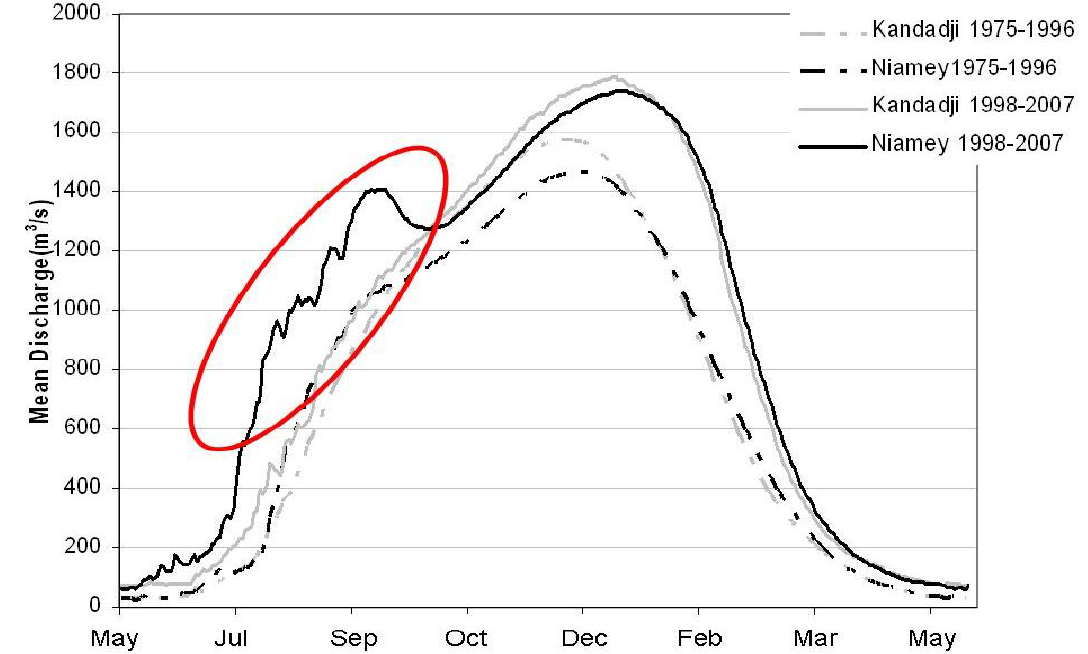
Figure 7. Average hydrographs of the Niger River at Kandadji and Niamey stations for the periods 1975–1996 and 1998–2007.